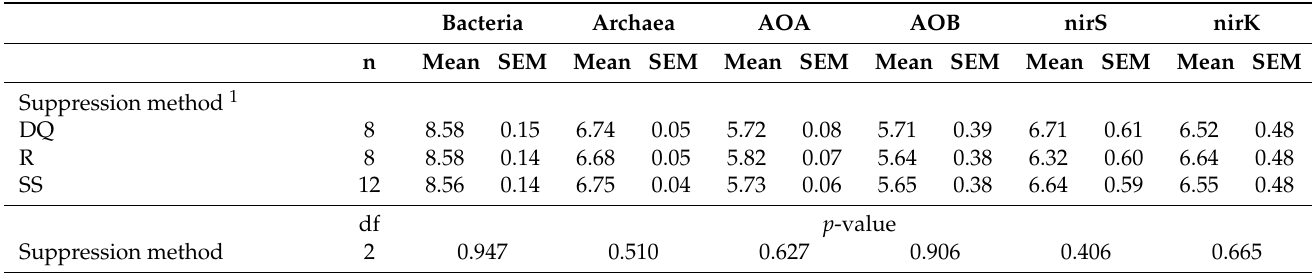
Table 2. Treatment mean values (mean), standard errors of the mean (SEM), number of observations (n), as well as probability values ( p -value), and degrees of freedom (df) associated with the ANOVA of copy number of indicator genes (log 10 transformed) from different microbial groups in the rhizosphere of oats.